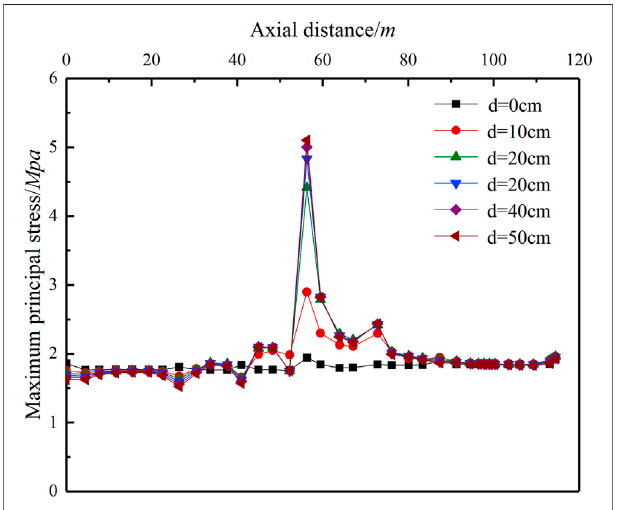
FIGURE 11 | Maximum principal stress curve of underground utility tunnel obliquely crossing the ground fi ssure (inclination 90 ° ).